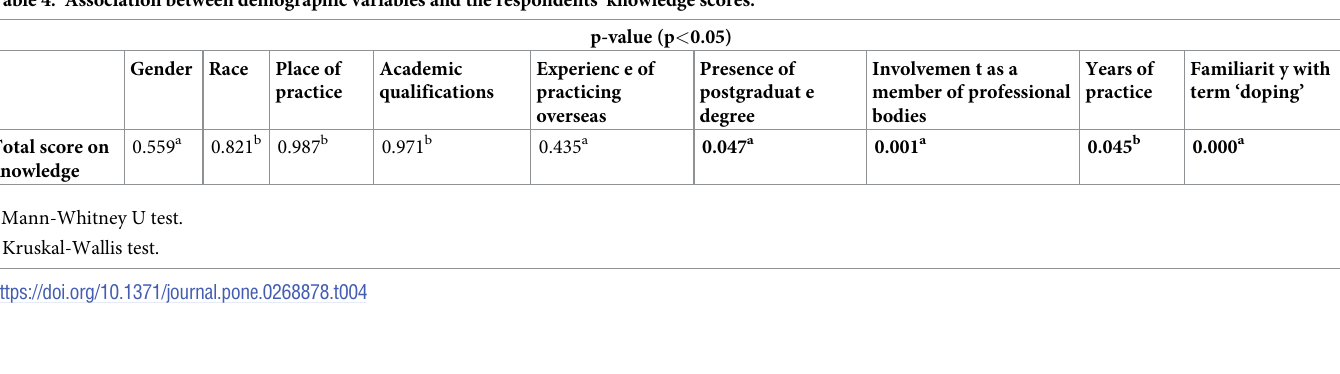
Total scores of the respondents’ doping-related knowledge. Based on their total knowl- edge scores, the respondents were classified as having poor, moderate, or good levels of knowl- edge of doping in sports (Table 3).